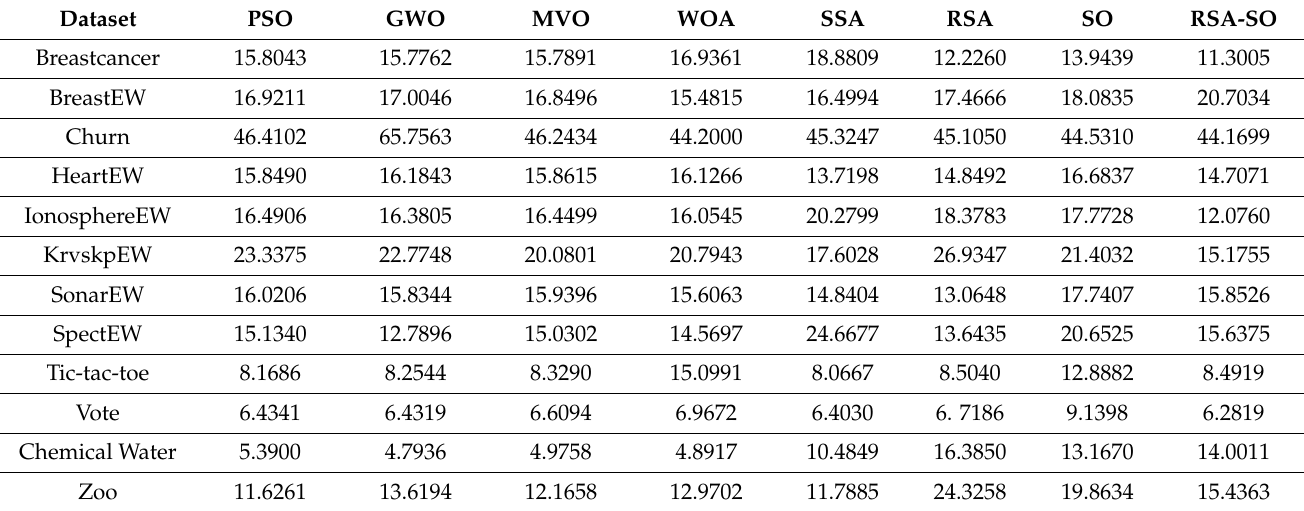
Table 6. Comparison between RSA-SO and other methods in terms of computation